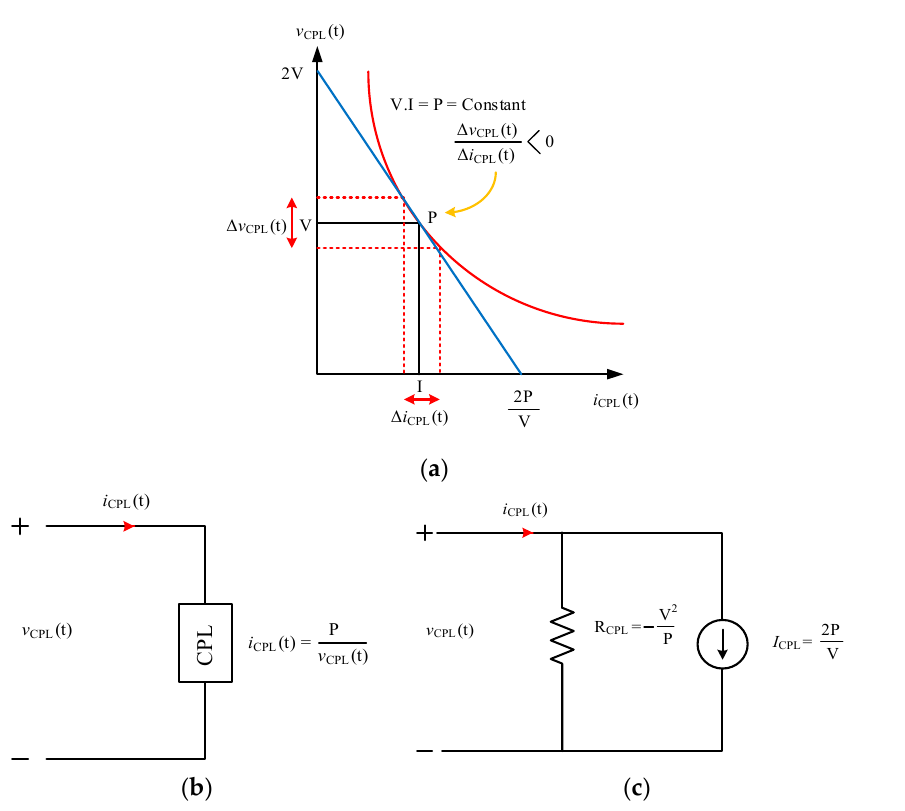
Figure 2. ( a ) Constant power load V-I Characteristics. ( b ) Large signal CPL model. ( c ) Small signal CPL model.